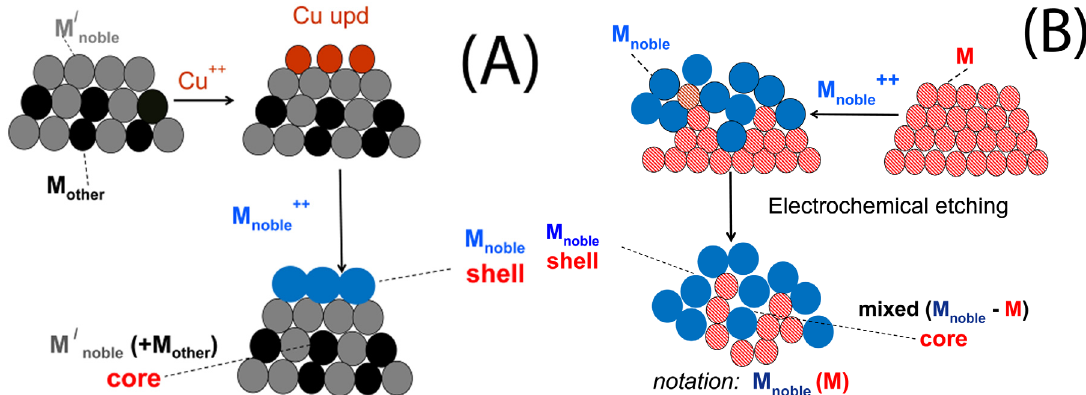
Figure 1. Schematic representation of the mechanism of the two main approaches for galvanic replacement at an atomic level: ( A ) Replacement of Cu upd monolayer, formed on a noble metal M ’ noble substrate (that may also contain another metal, M other ), by the noble metal of interest, M noble ; ( B ) replacement of atoms of a reactive metal substrate, M, by the noble metal of interest, M noble , followed by electrochemical etching/anodization.